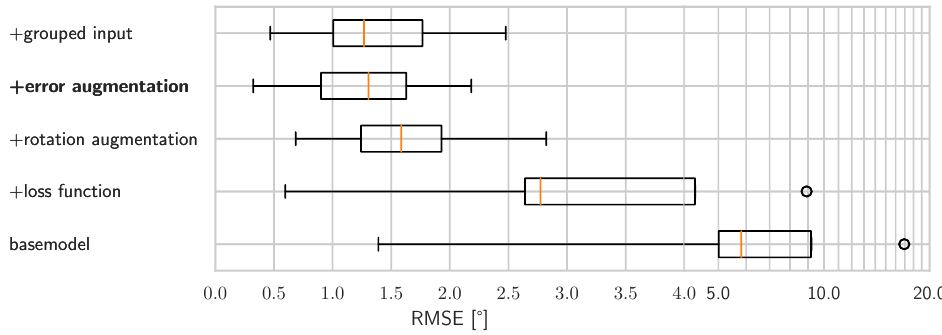
Figure 6. Ablation study of domain-specific advances, which are added successively (bottom to top). The RMSE distributions over 12 validation sequences are compared. Adaptations of the loss function and data augmentation have the largest impact on accuracy. Bold font indicates the chosen final